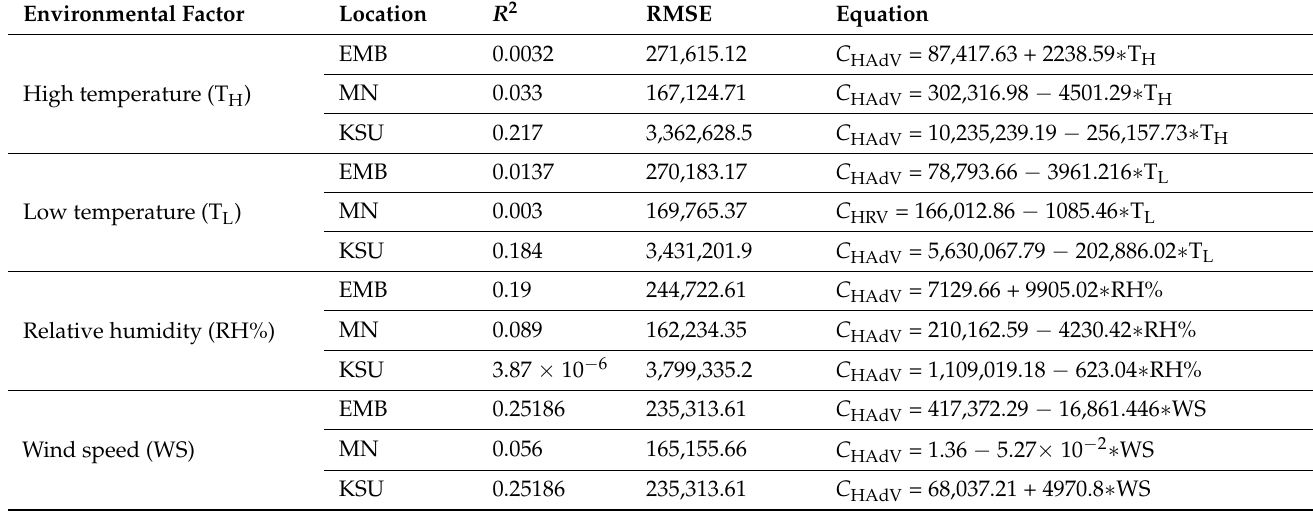
Table 3. Significance of environmental factors’ influences on the concentration of HAdV.